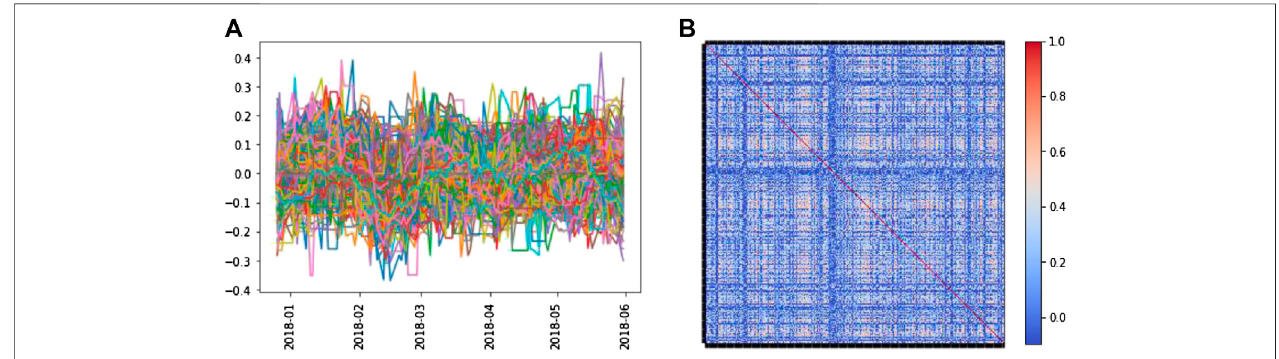
FIGURE1|(A) Thederivative dataofa6-month periodcollectedfromSTI. (B) Thecrosscorrelation matrixisgeneratedfromthederivativedatain (A) .Forthetime series and correlation matrices in this work, we will not show error bars to not distract the readers from the overall features.